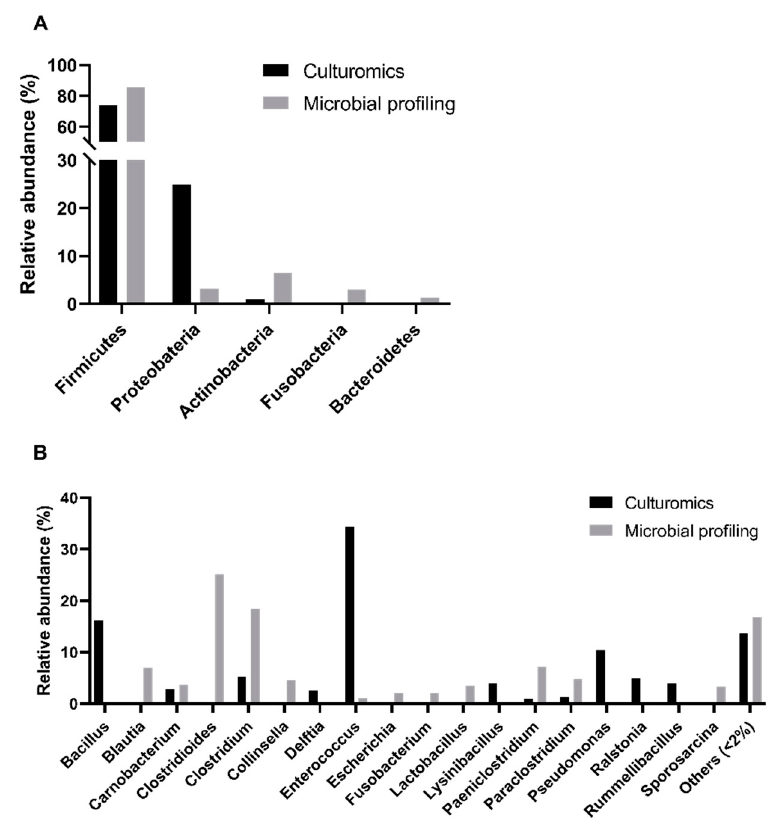
Figure 2. Comparison of the intestinal bacterial microbiota of the Egyptian mongoose between culturomics and microbial profiling [10] approaches. ( A ) Relative abundance at a phylum level; ( B ) Relative abundance at the genus level.